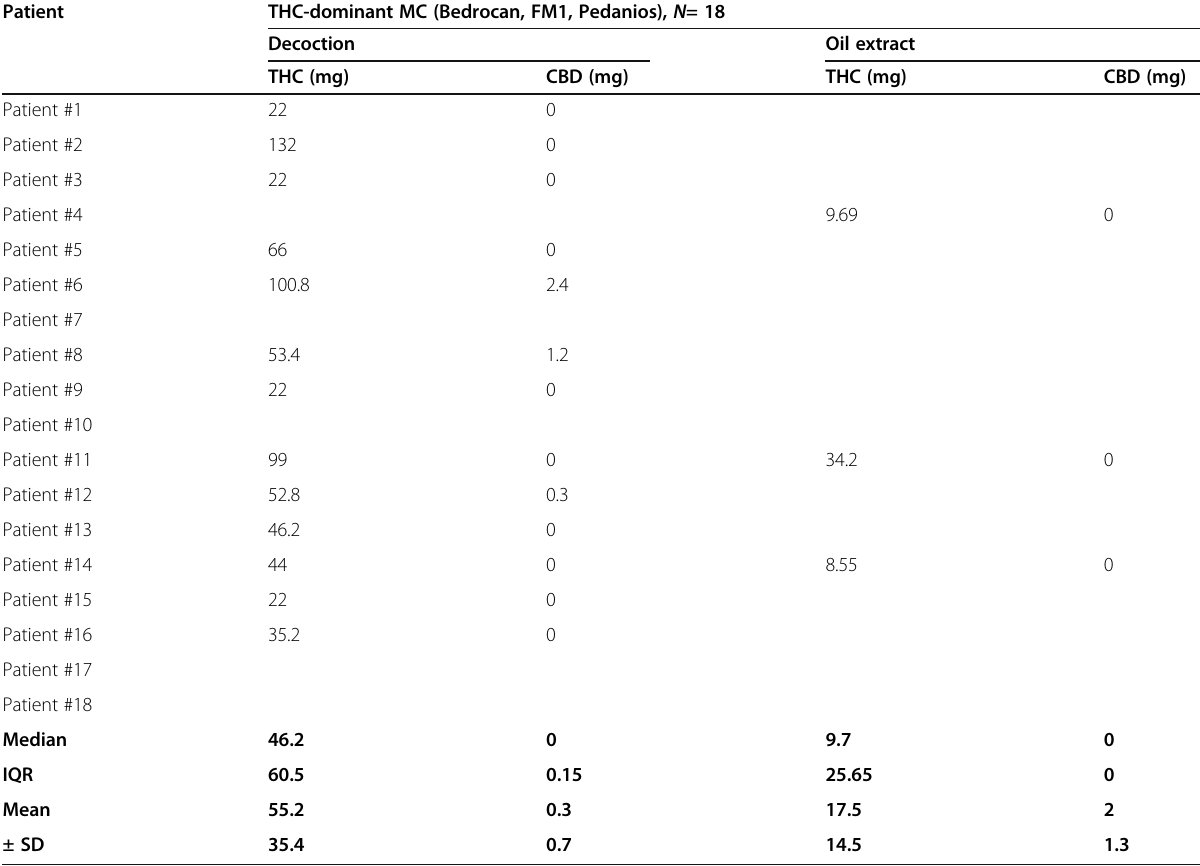
Table 11 Dosage of THC and CBD administered with dominant THC medical cannabis to fibromyalgia patients